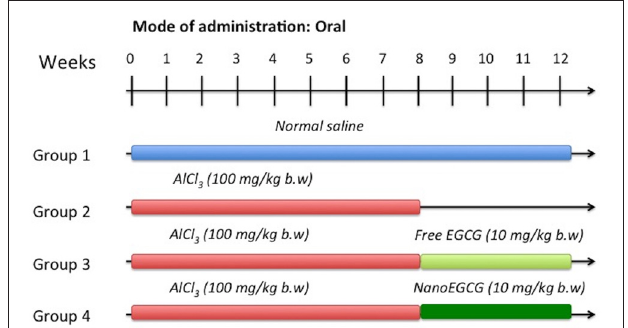
FIGURE 1 | Experiment strategy for aluminum chloride (AlCl 3 ) induction, free epigallocatechin-gallate (EGCG) and EGCG nanoparticle (nanoEGCG) treatment in wistar